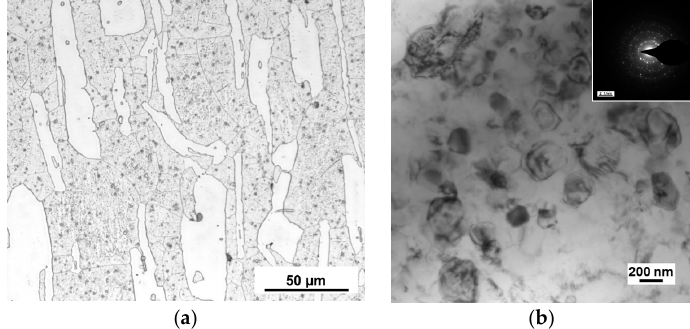
Figure 5. Microstructure of Mg-Li alloy: ( a ) OM images original condition; ( b ) TEM observation processed by HPT after 10 turns.